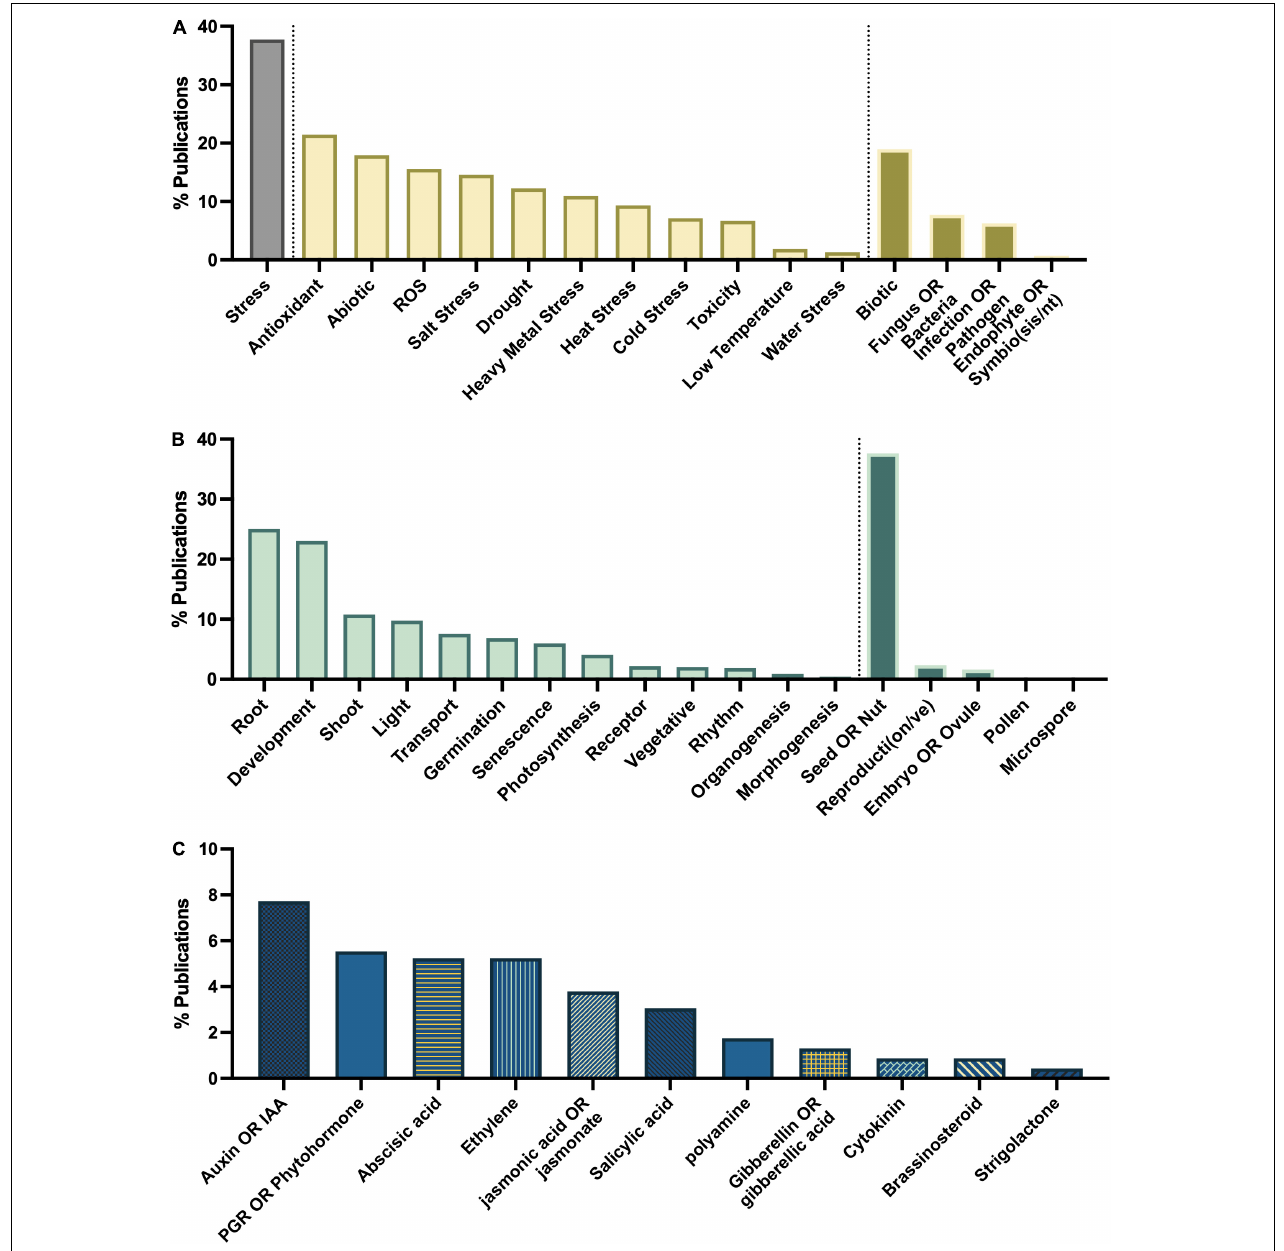
FIGURE 8 | Major themes in melatonin literature number of papers on topics associated with (A) stress, (B) growth and development, (C) interaction with